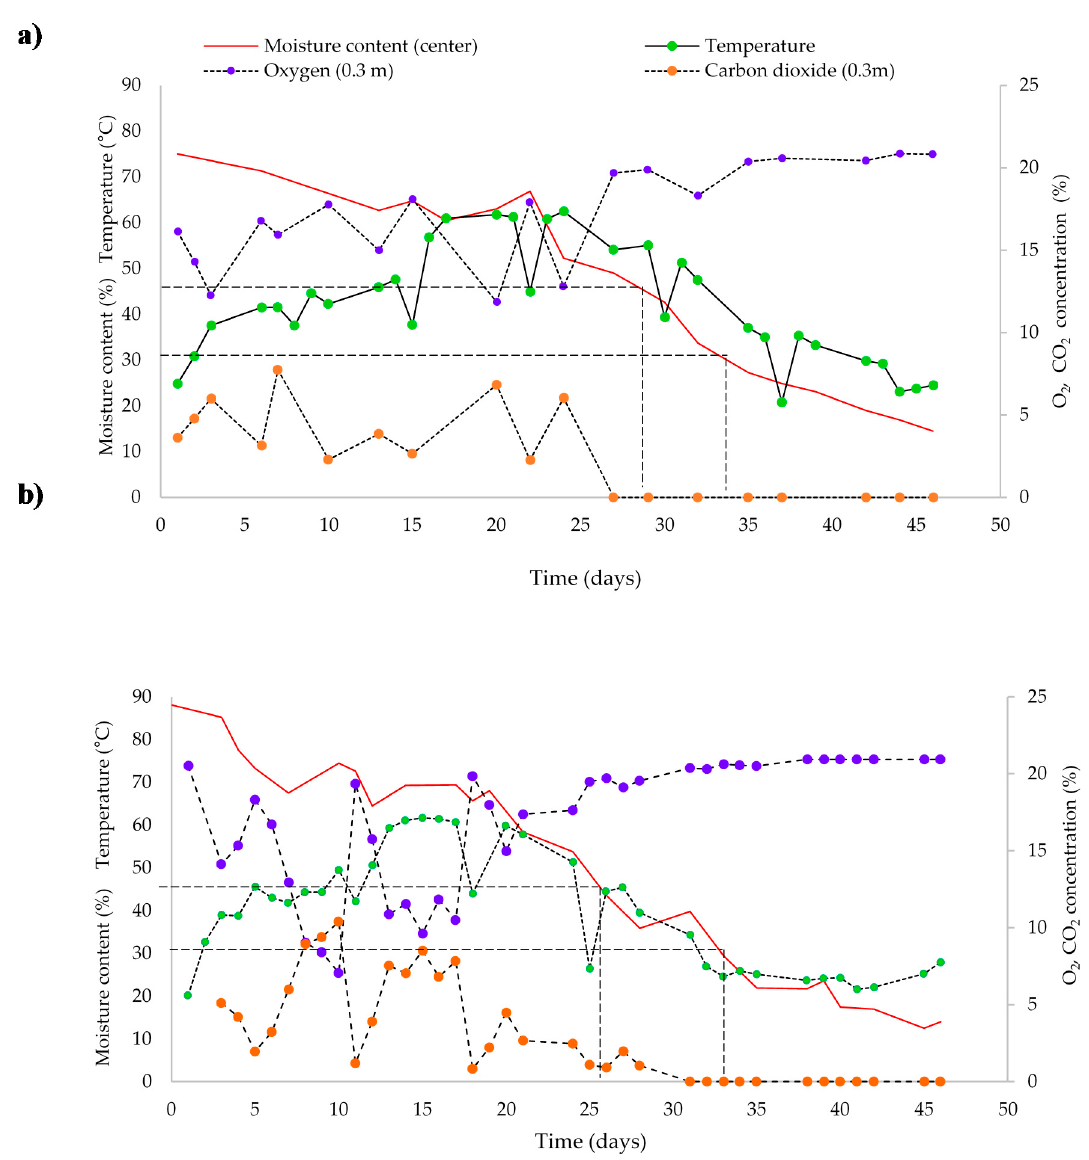
Figure 4. Behavior of %O 2 and %CO 2 at 0.3 m depth, of center temperature and center moisture of P1 ( a ) and P2 ( b ).